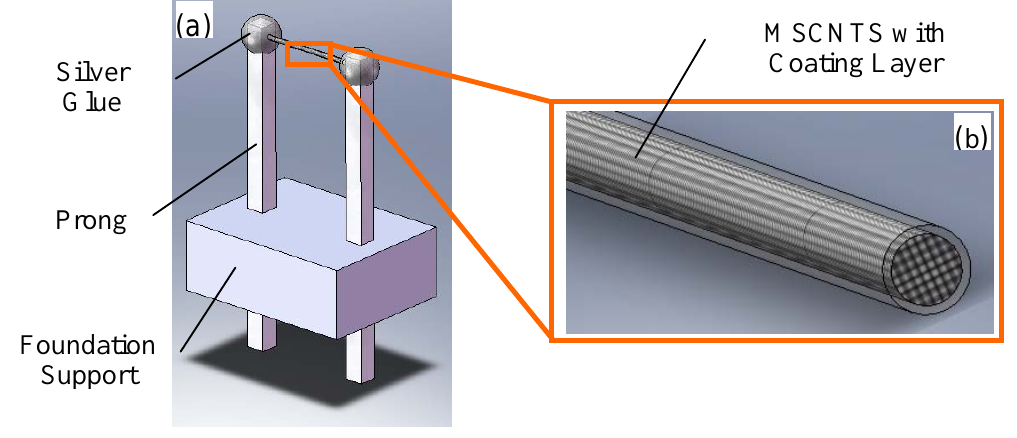
Figure 1. (a) Schematic diagram of the MSCNTS flow-rate sensor and (b) the enlarged view of the MSCNTS which shows the MSCNTS is composed of many individual CNTs (the MSCNTS was cut off for showing its